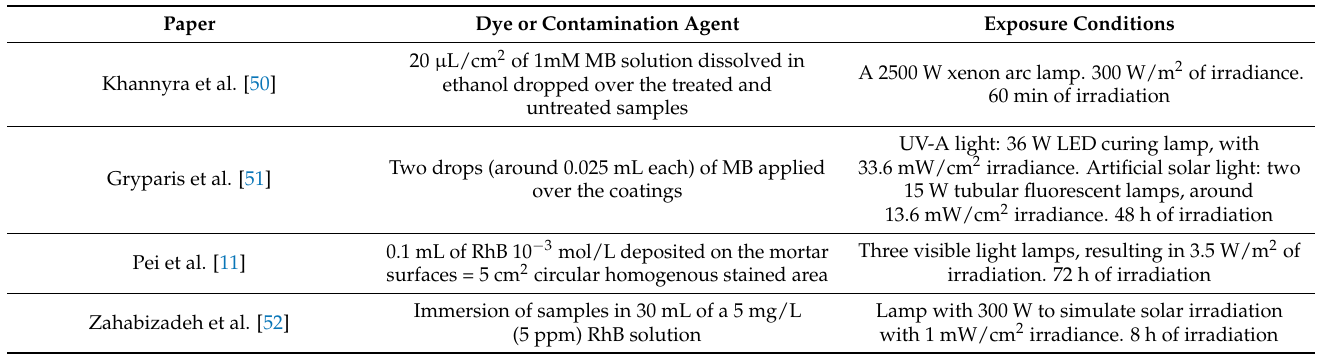
Figure 5. Application of different dyes or contamination agents to evaluate self-cleaning ability. Note: one of the papers [66] used tobacco extract and Rhodamine B. Table 4. Details on the applied dye or contamination agents and the main exposure conditions for testing the self-cleaning ability.